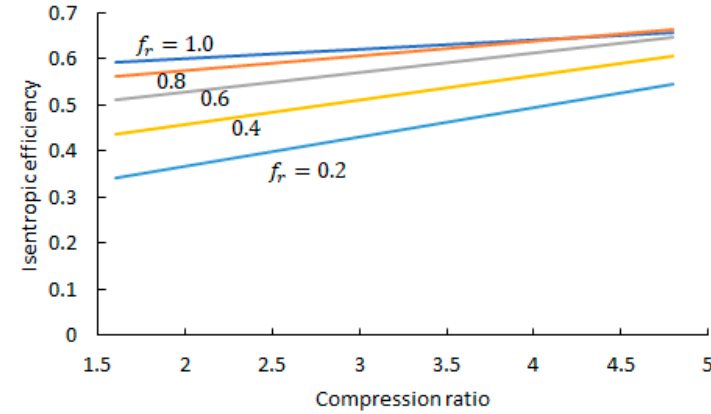
Figure 4. Isentropic efficiency of the compressor.